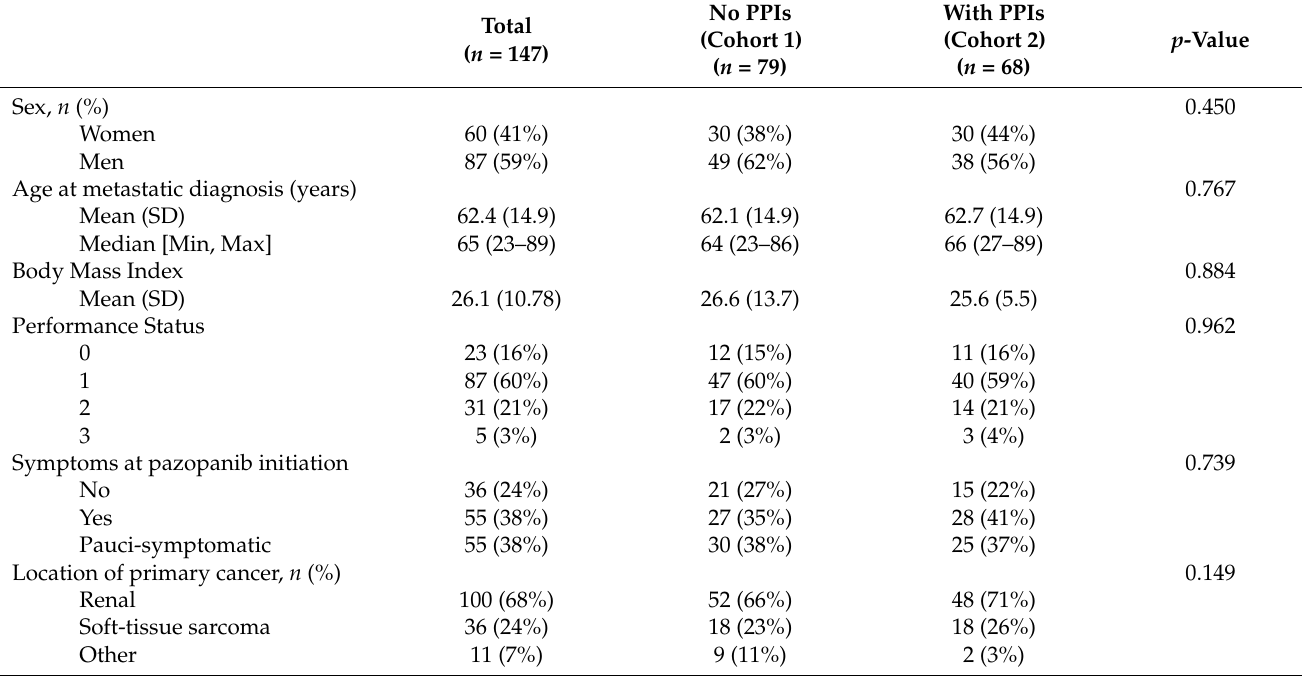
Table 1. Patient